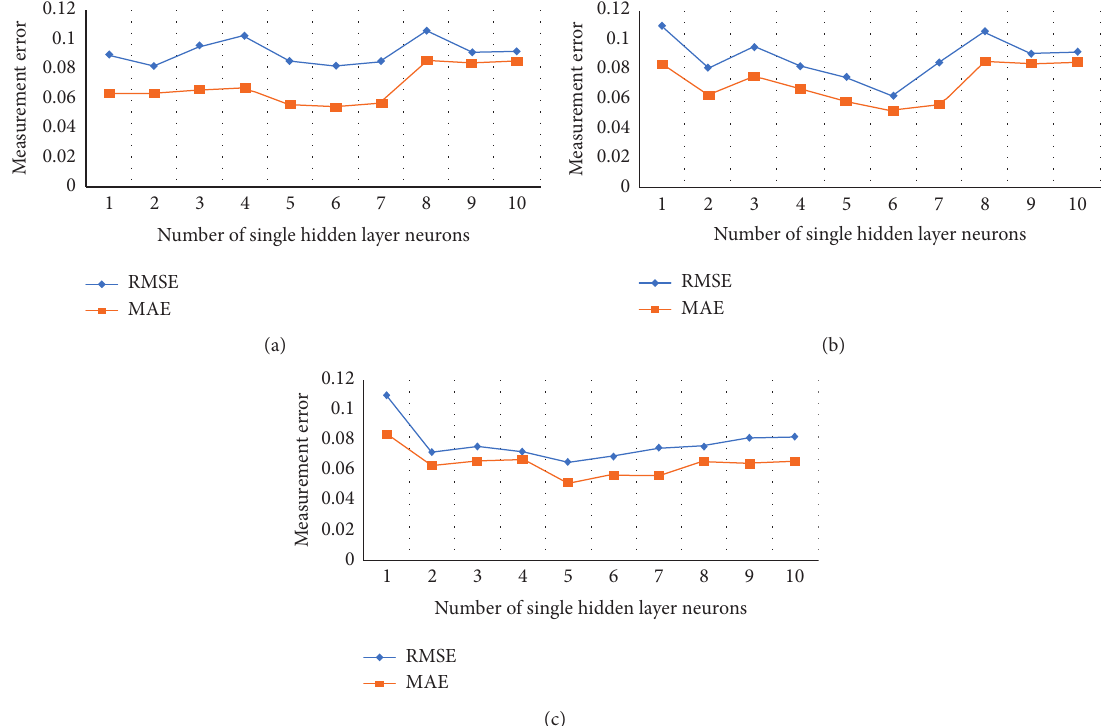
Figure 16: Training error with the number of neurons. (a) Single hidden layer neuron change chart. (b) Second hidden layer neuron change chart. (c) Third hidden layer neuron change